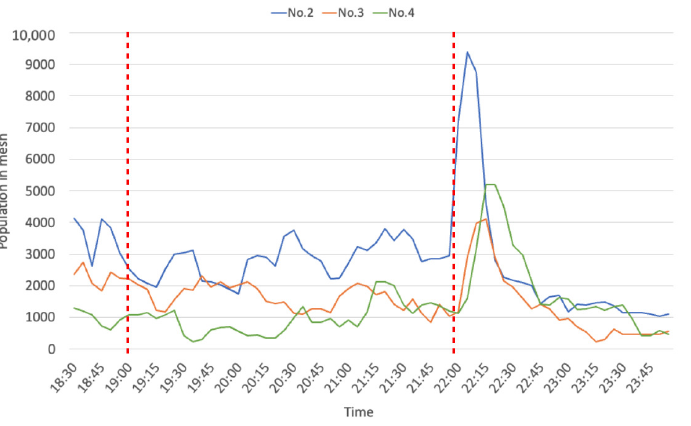
Figure 5. Time series of population movement en route to the nearest station (13 July).